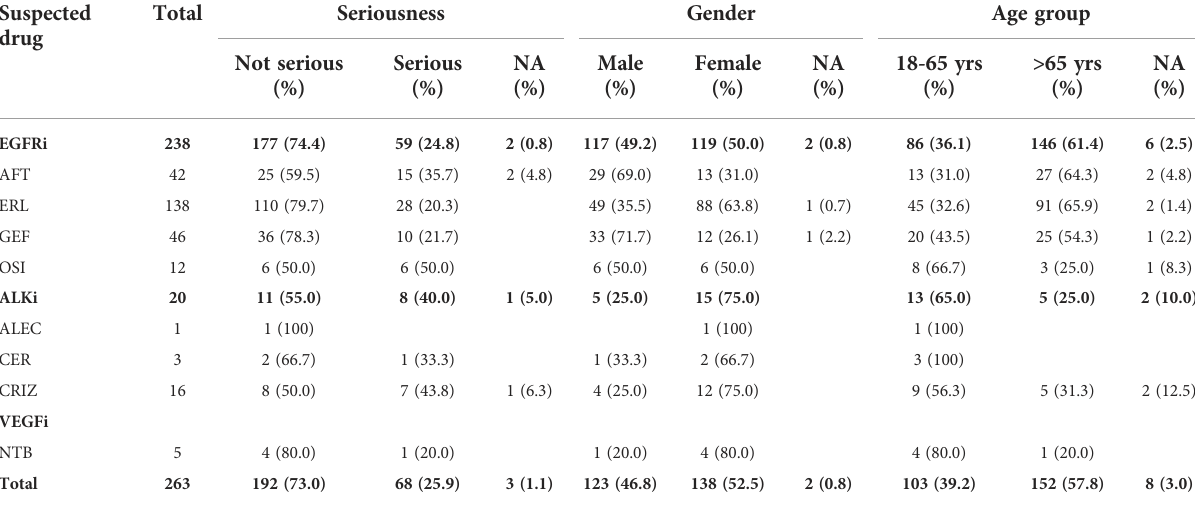
TABLE 3 Descriptions of Sicilian ADR reports related to TKIs for NSCLC collected into the RNF from January 2006 to December